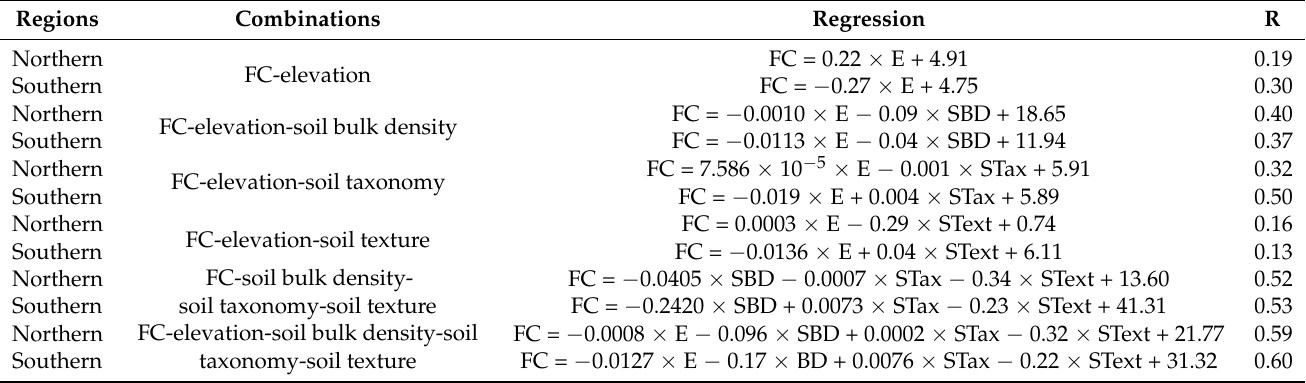
Table 2. Using data from 2001 to 2015, regressions and correlations of ln(FC) as a function of elevation vs. as a function of a combination of soil properties and elevation. Elevation—(E), soil bulk density—SBD, soil taxonomy—STax, and soil texture—SText.